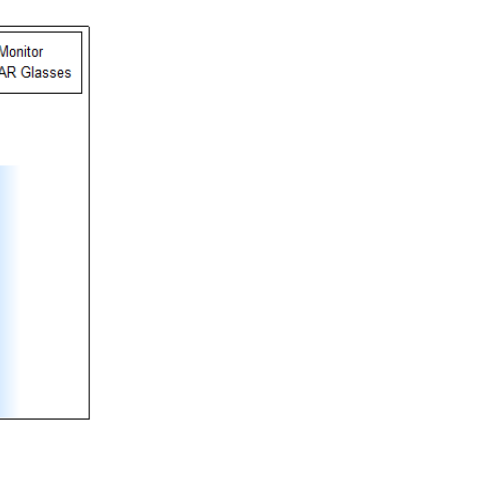
Figure 10. Comparison of the blink rate in the monitor environment and AR glasses environment (*: p < 0.05).